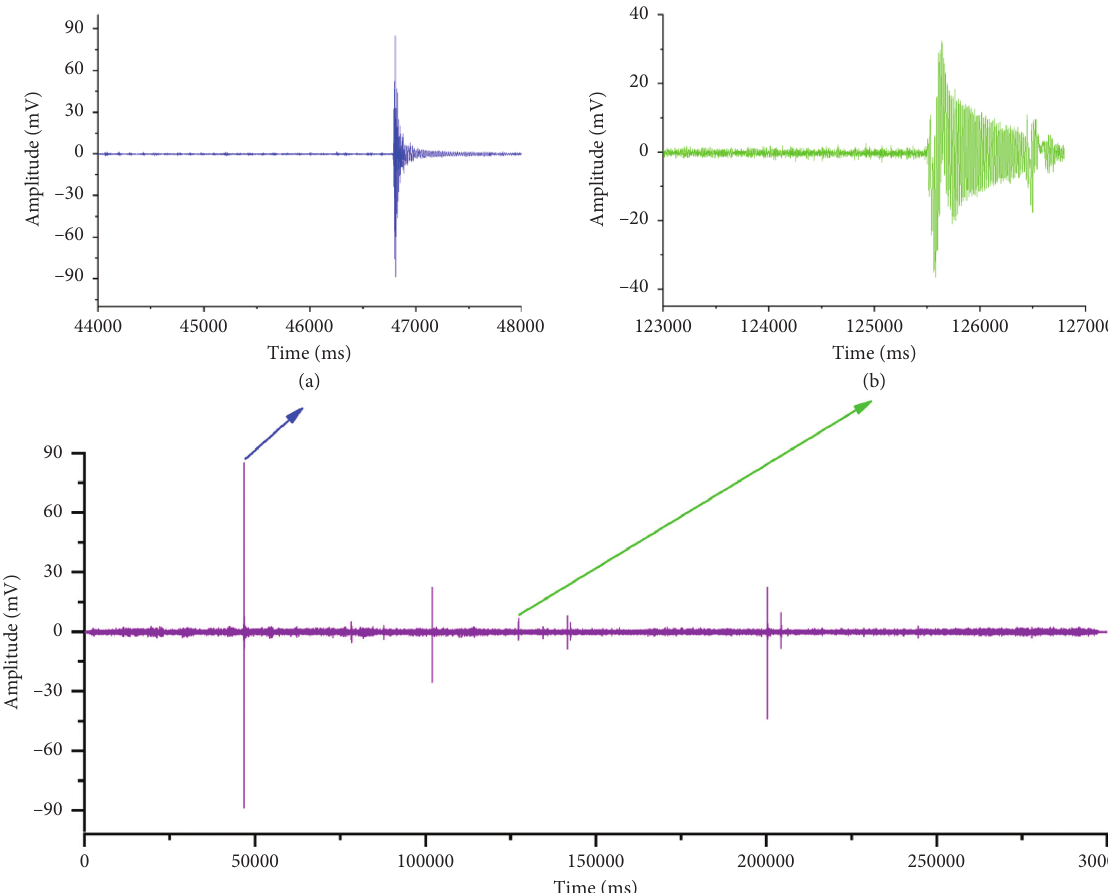
Figure 2: Waveforms measured by 3# detector. (a) Waveform of vibration event. (b) Waveform of sticking.